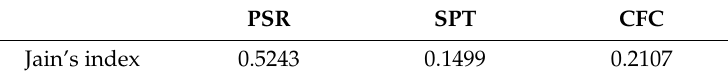
Figure 7. Distribution of different methods. Table 2. Value of Jain’s index for each mechanism.